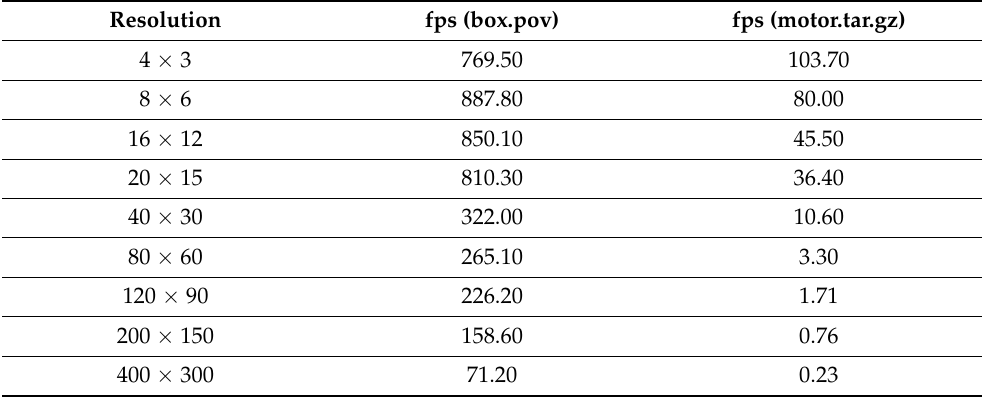
Table 3. Benchmarking results for a test scene and for a real-life model of a Tesla electric